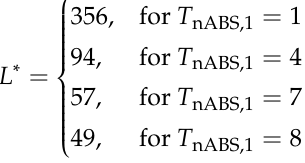
Table 2. The minimum value of L to satisfy the spectral e ffi ciency and energy e ffi ciency requirements of 5G